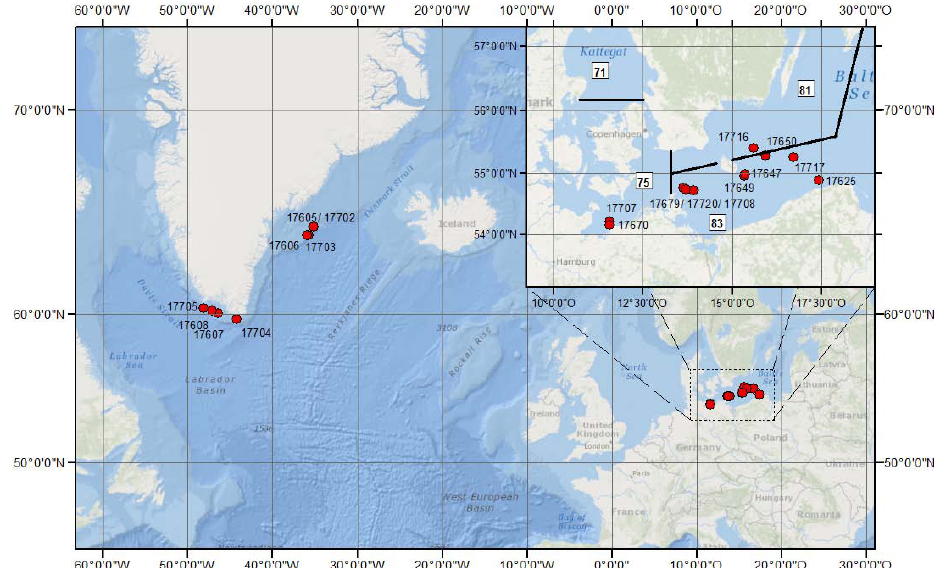
Fig. 1. Sites for sampling of cod, redfish and whiting (see Table 1 for sample details) for analysis of radioactivity in the Labrador Basin and the BS (scale of the large map is 1 : 42 . 000 . 000; scale of the small map is 1 : 10 . 000 . 000). The small map of the BS contains the borders and nomenclature of the water boxes (numbers in boxes: 71 = Kattegat, surface; 75 = Belt Sea, surface; 81 = BS west, surface; 83 = BS east, surface) for estimation of the Cs behaviour using the modified HELCOM box model (see HELCOM, 1995, or Kanisch et al., 2000, for